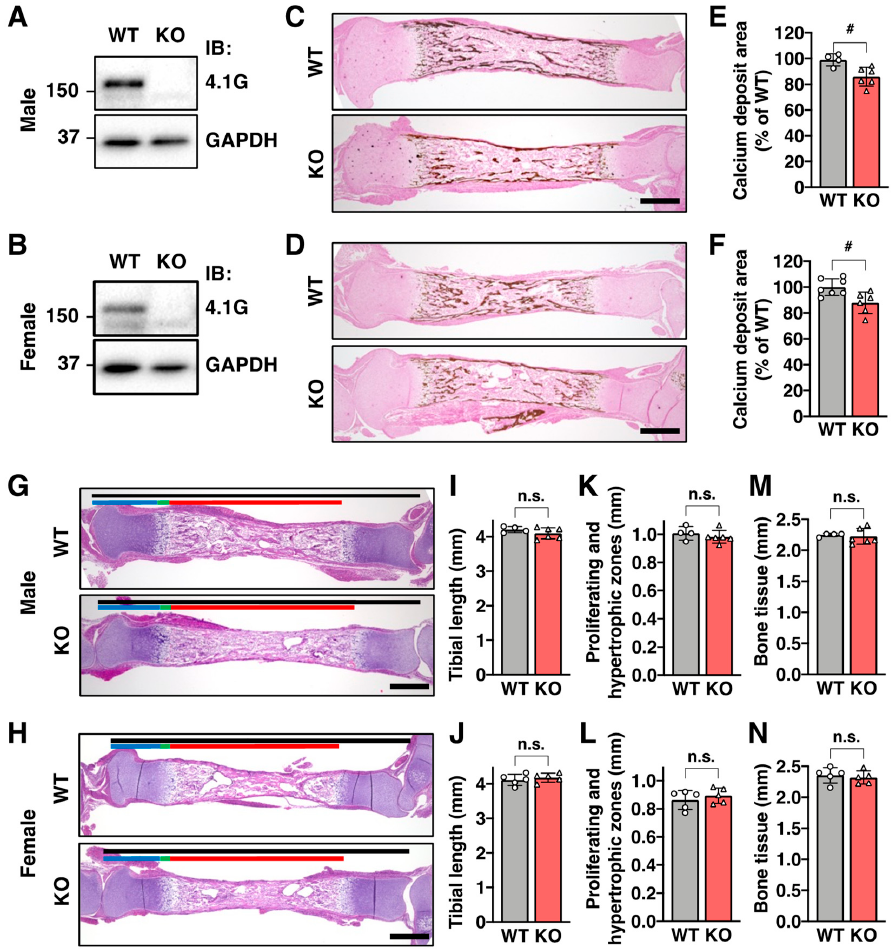
Figure 1. Protein 4.1G regulates osteogenesis of the newborn tibia. ( A , B ) Expression levels of 4.1G in wild-type (WT) and 4.1G-knockout (KO) femur. Femurs were isolated from the 4-week-old male ( A ) and female ( B ) mice. Expression levels of 4.1G were analyzed by Western blotting. Cell lysates were immunoblotted (IB) with the anti-4.1G or anti-glyceraldehyde-3-phosphate dehydrogenase (GAPDH) antibody. ( C – F ) Calcium deposit. Newborn tibia sections from the male ( C , E ) and fe- male ( D , F ) mice were stained by modified von Kossa’s reaction. ( E , F ) The area of calcium deposit was calculated as %WT of tibia. ( G – N ) Tibia morphology. Newborn tibia sections from the male ( G , K , M ) and female ( H , J , L , N ) mice were stained with hematoxylin and eosin. Black bar, whole tibia; blue bar, proliferating zone; green bar, hypertrophic zone; red bar, bone tissue. The length of the whole tibia ( I , J ), proliferating and hypertrophic zones ( K , L ), and bone tissue ( M , N ). Data are presented as the mean ± standard deviation (S.D.) from 4 (( E ); WT), 6 (( E ); KO), 7 (( F ); WT), 6 (( F ); KO), 4 (( I , K , M ); WT), 6 (( I , K , M ); KO), 5 (( J , L , N ); WT), and 5 (( J , L , N ); KO) independent experiments. # p < 0.05, Student’s t -test. n.s., not significant. Scale bars, 500 µ